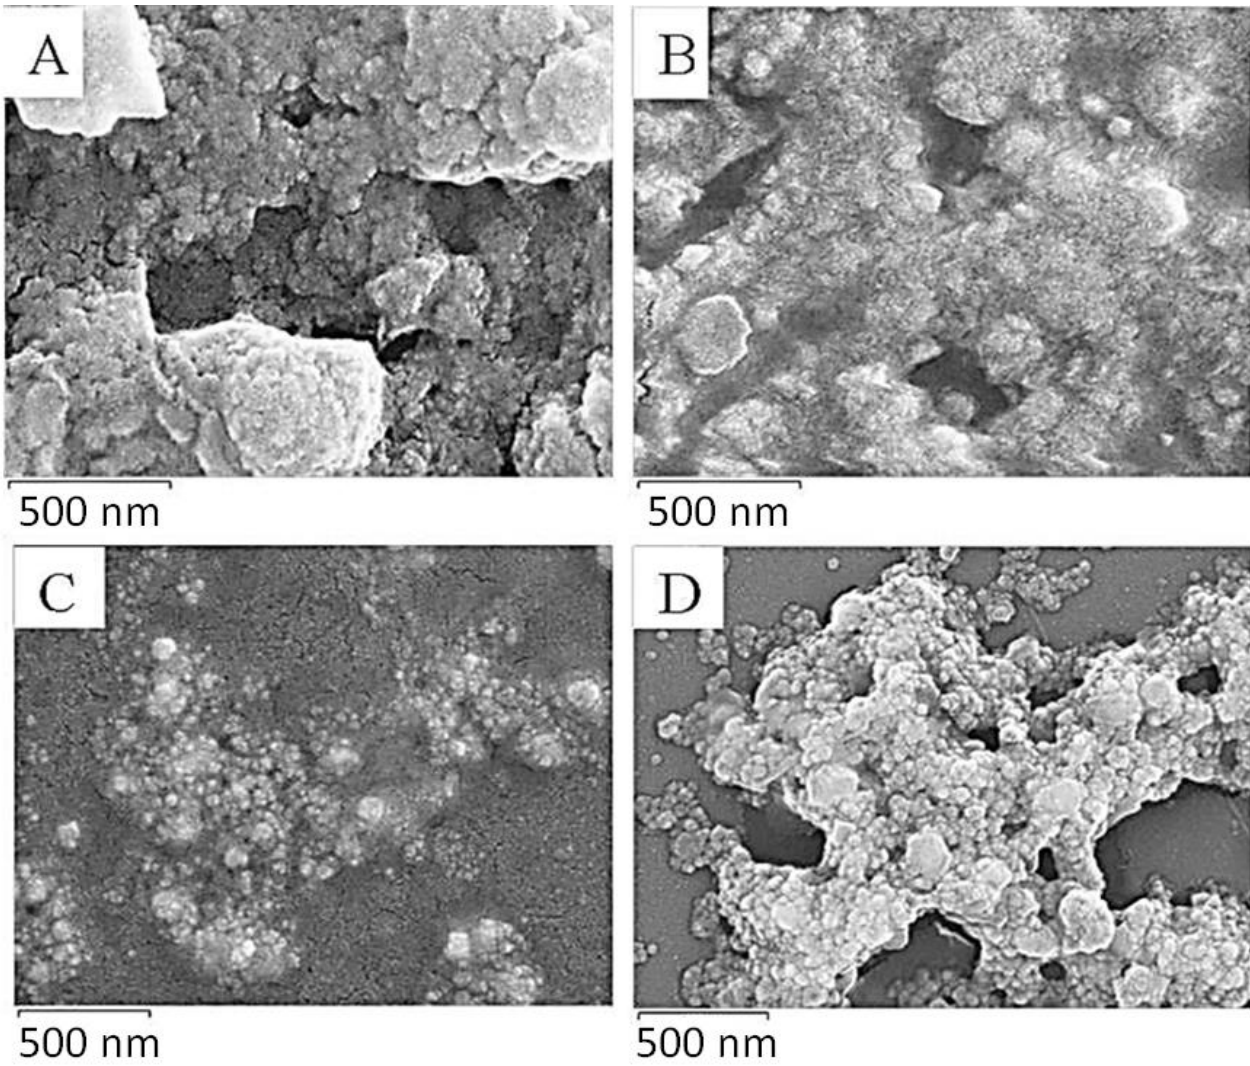
Figure 4. SEM images of D. villosa leaves ( A , B ) and stem bark ( C , D ) AgNPs synthesized at room temperature and at 80 °C, respectively.